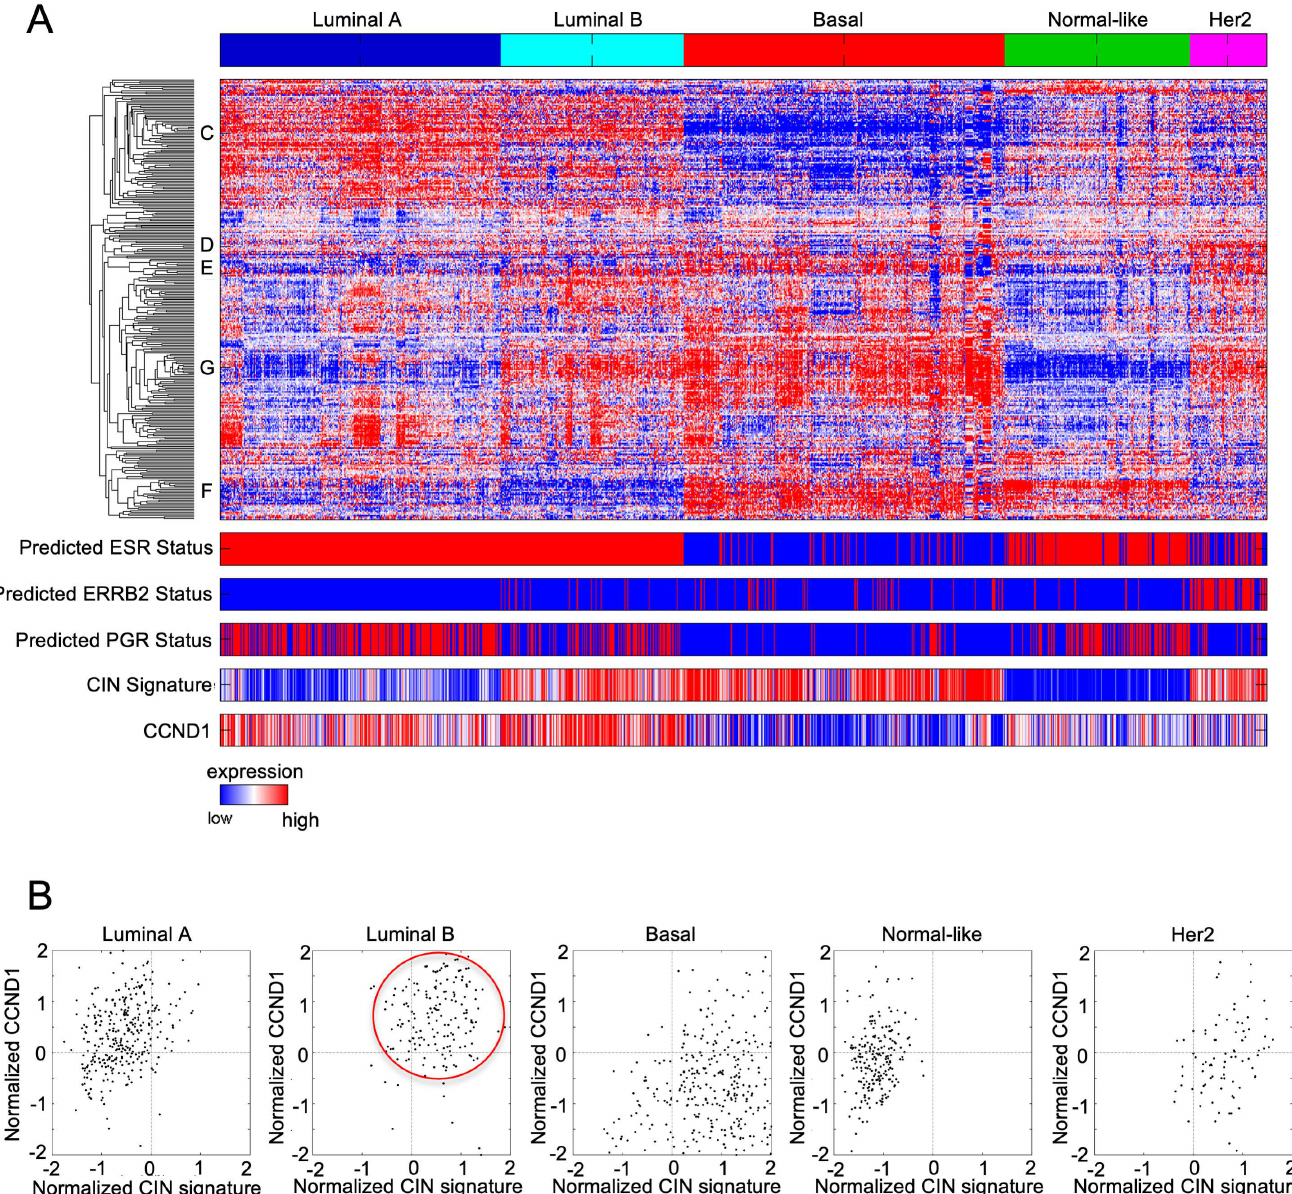
Figure 3. Chromosomal instability signature and cyclin D1 expression in breast cancer subtypes. ( A ) Heatmap of breast cancer microarray datasets assigned to the breast cancer coding genome